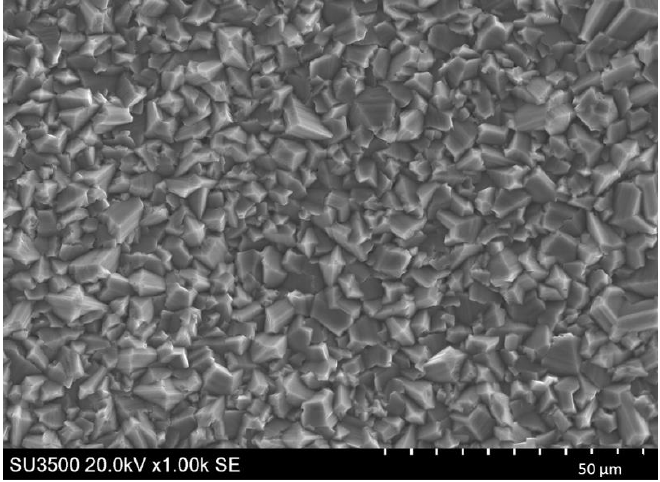
Figure 7. SEM surface morphology of the oxidized Ti at 700 ◦ C for 100 hours.